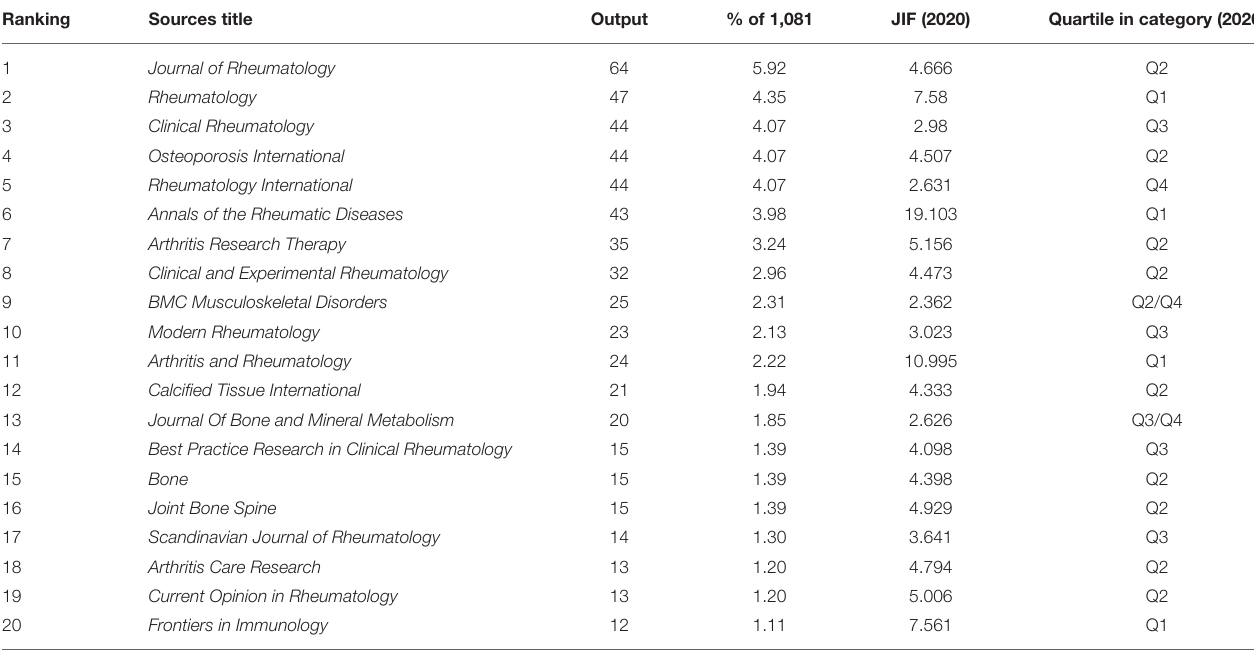
TABLE 2 | Top 20 journals with most publications in the field of ORA